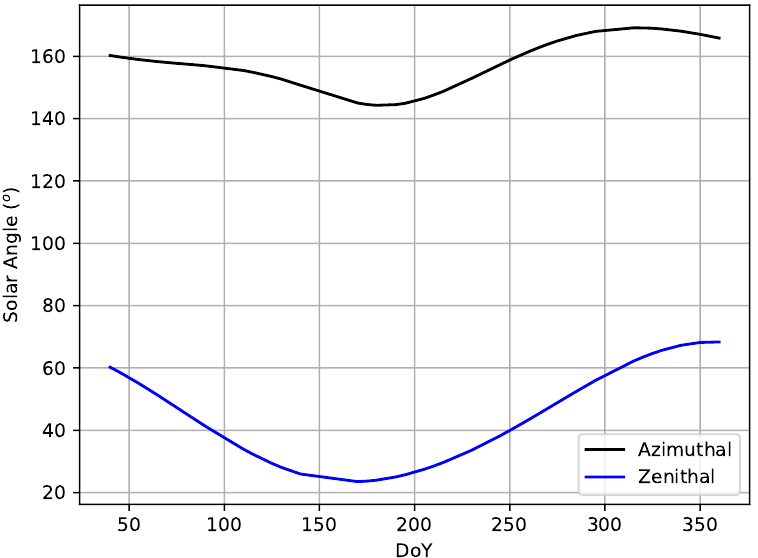
Figure 2. Toulouse (France) zenithal and azimuthal illumination angles at S-2 acquisition time (11:00) as a function of the Day of the Year